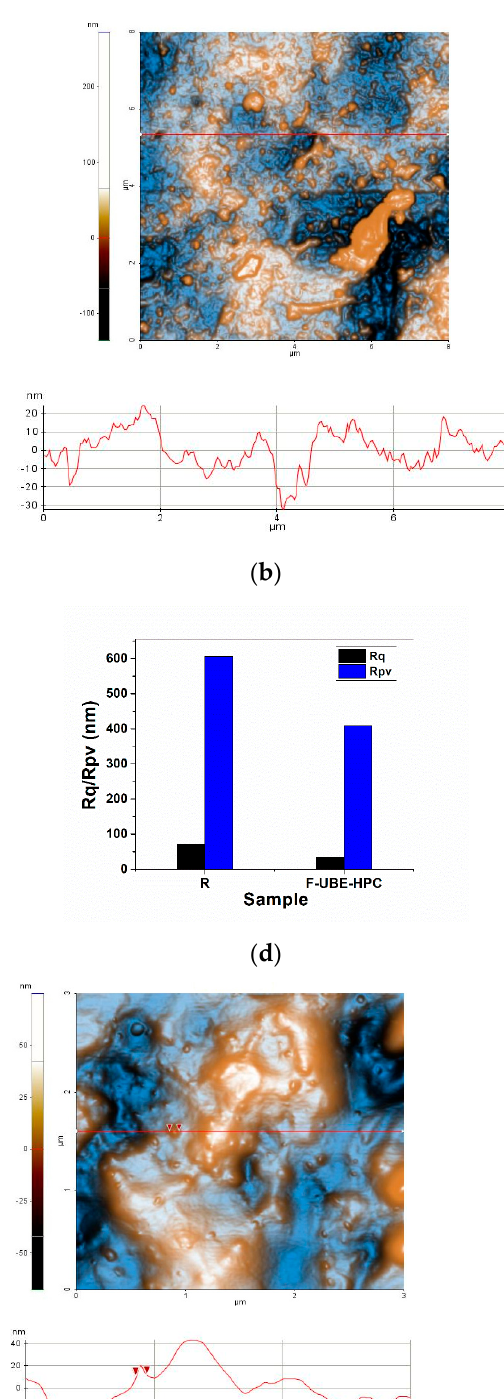
(enhanced contrast view) at the scale of (3 × 3) µm 2 together with representative line-scans for the valley (Rpv) parameters ( c ) along the line scans and ( d ) for the whole scanned areas; 2D AFM images films ( e ) R and ( f ) F-UBE-HPC; R—bioadhesive oral film without active lichen extract; F-UBE-HPC—bioadhesive oral film loaded with U. barbata dry ethanol extract.